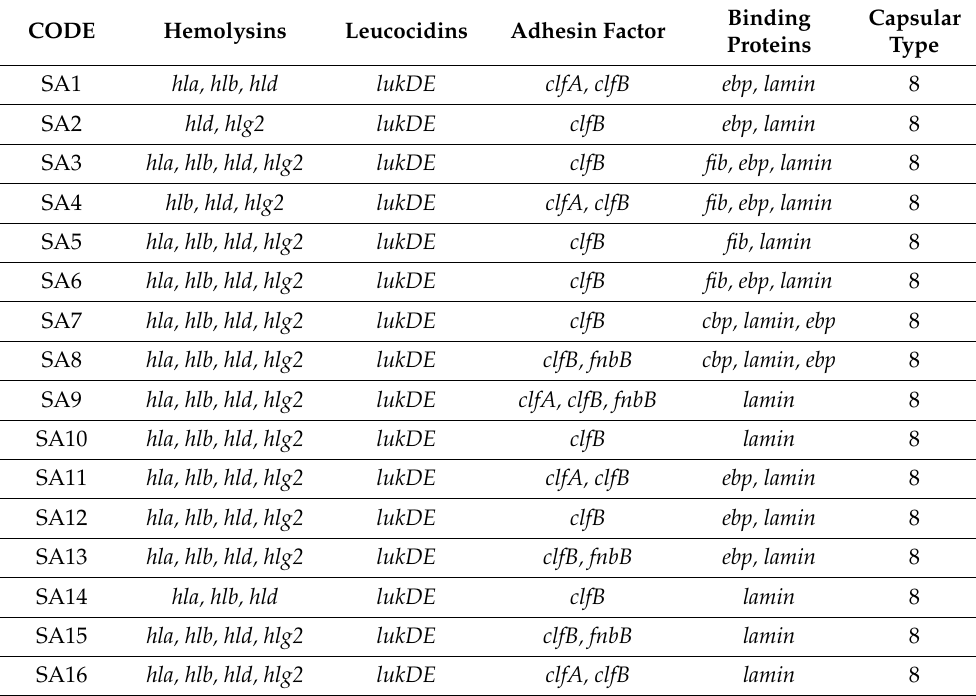
Table 1. Virulence-associated genes of the 16 MSSA isolated from the healthy